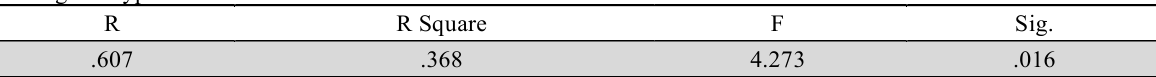
Testing the hypothesis R R Square F Sig. .607 .368 4.273 .016